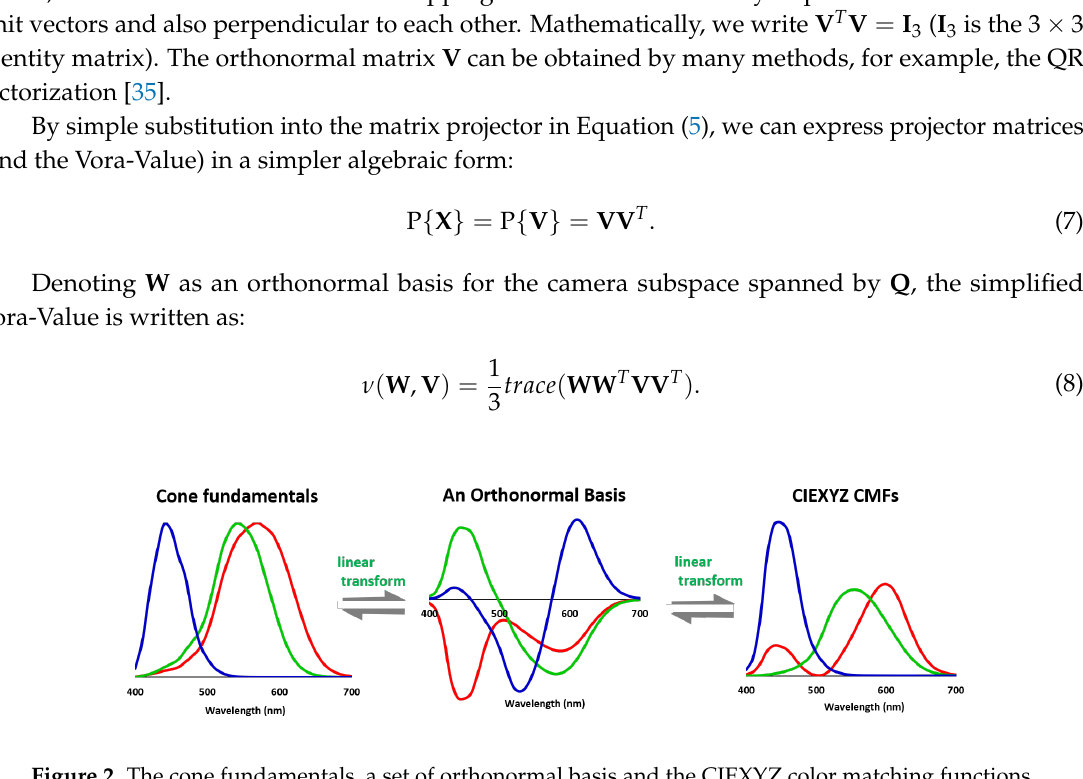
Figure 2. The cone fundamentals, a set of orthonormal basis and the CIEXYZ color matching functions (CMFs) are all linearly related, i.e., they can be converted to each other via a linear combination. All three sensitivity sets span the same vector space of the human visual